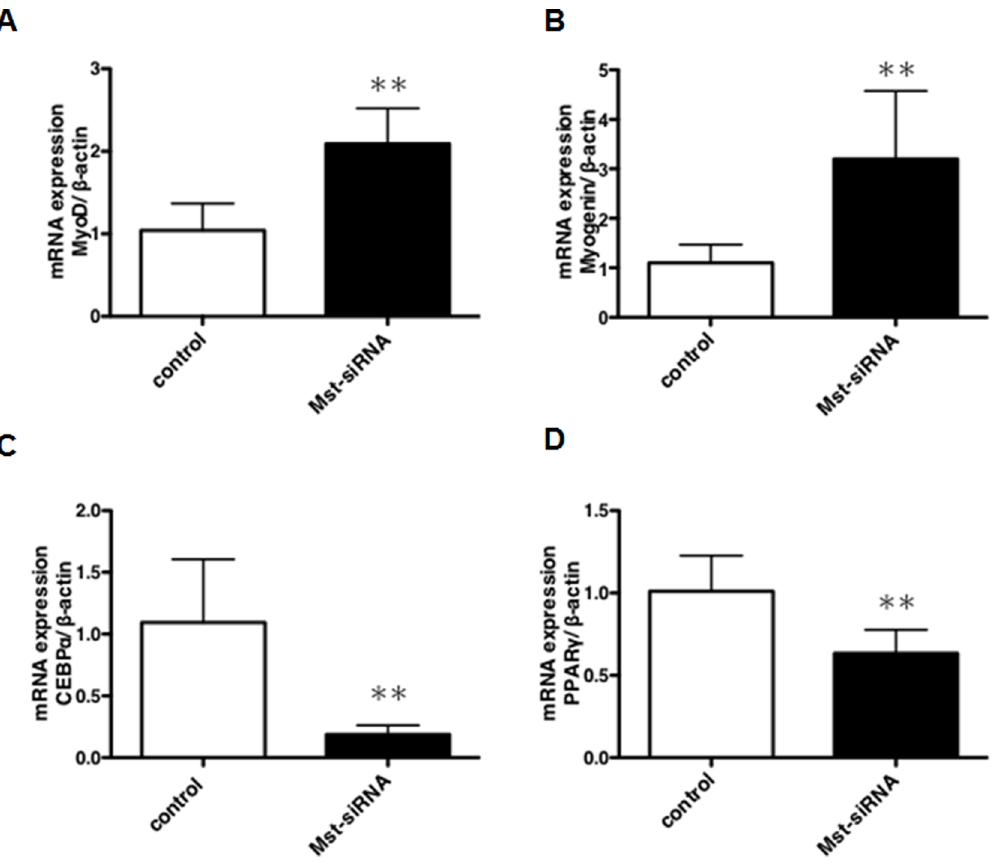
Figure 2. Effect of local administration of the Mst-siRNA/ATCOL complex on the gene expression levels of MyoD , myogenin , PPAR c and CEBP a . The expression levels were first calculated as a ratio to GAPDH expression levels. Subsequently, the ratios of these genes were averaged to give the mean values indicated in the graphs. The data are expressed as the mean 6 SD. ** p , 0.01, n=12. (A) MyoD , (B) Myogenin , (C) PPAR c , (D) CEBP a